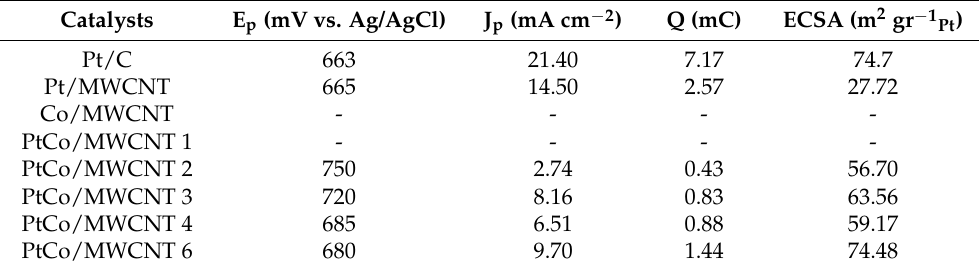
Table 3. Summary of the CO oxidation peak (E p ), CO current density peak (J p ), integrated electric charge (Q), and active surface area (ECSA) for the catalysts of this work. Catalysts